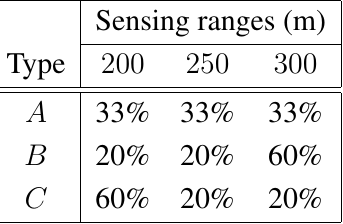
Table 2. Distribution of directional sensors with different sensing ranges.